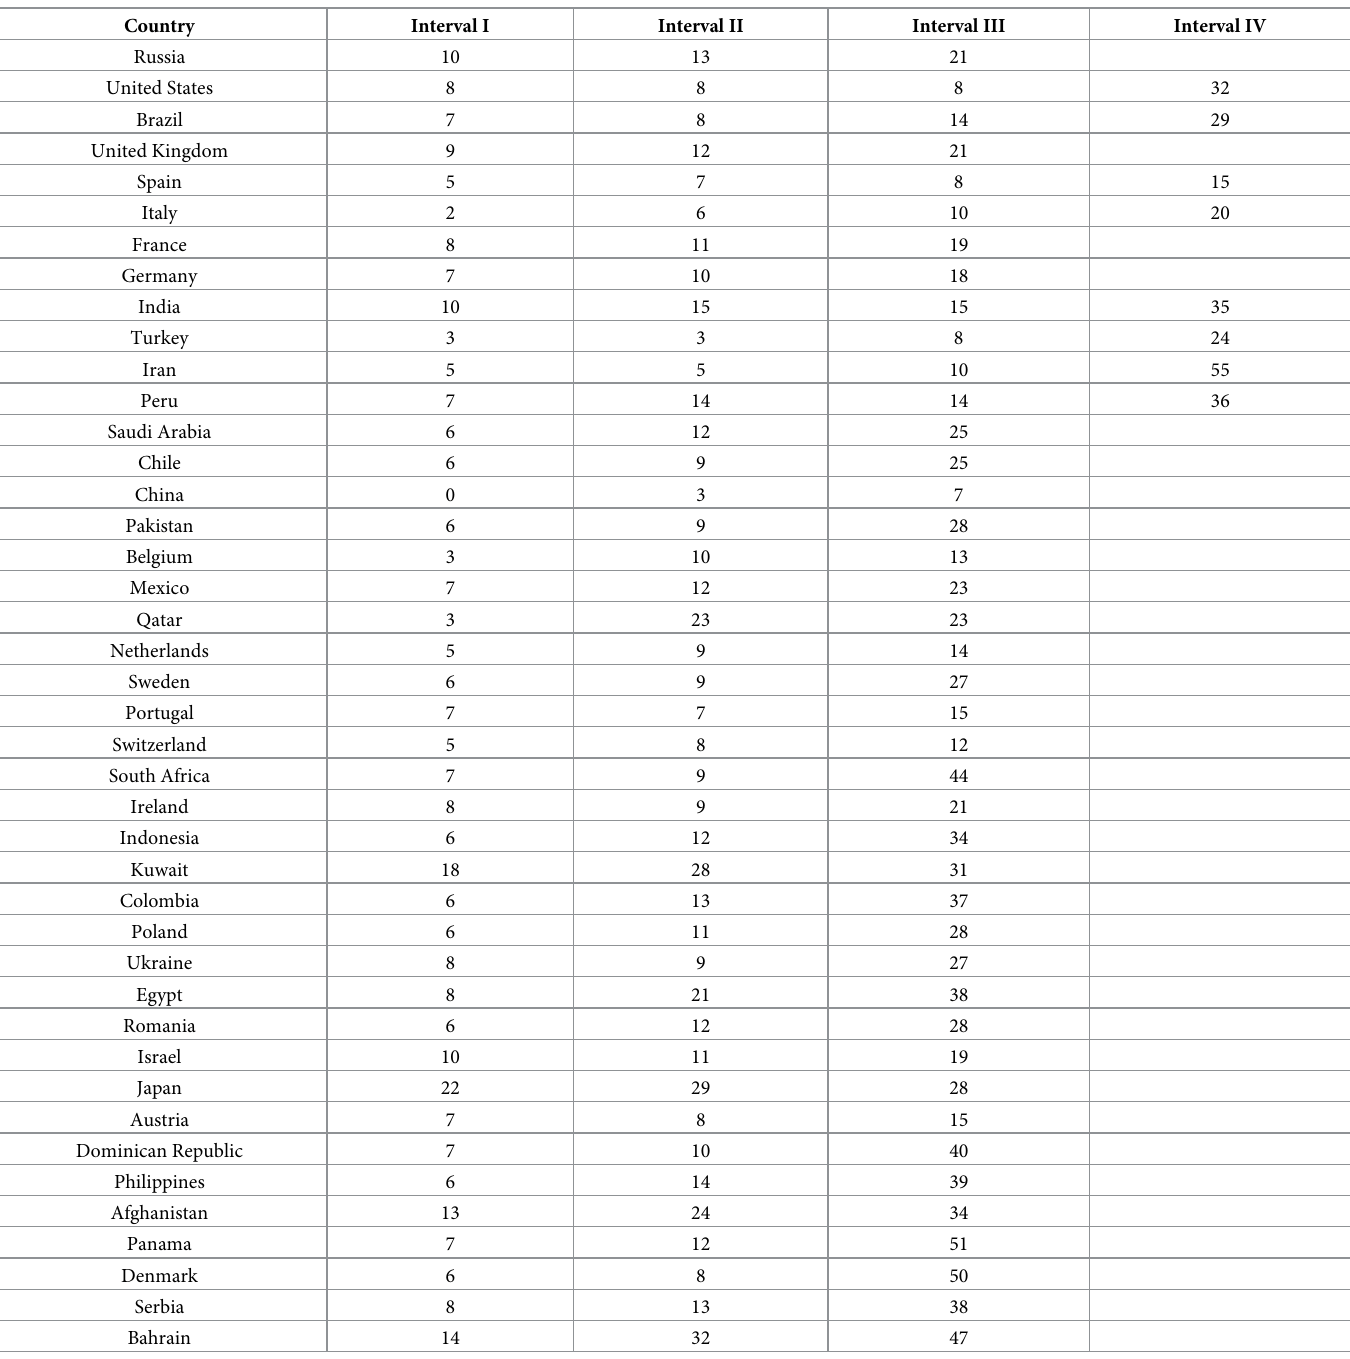
Table 4. Temporal intervals for 42